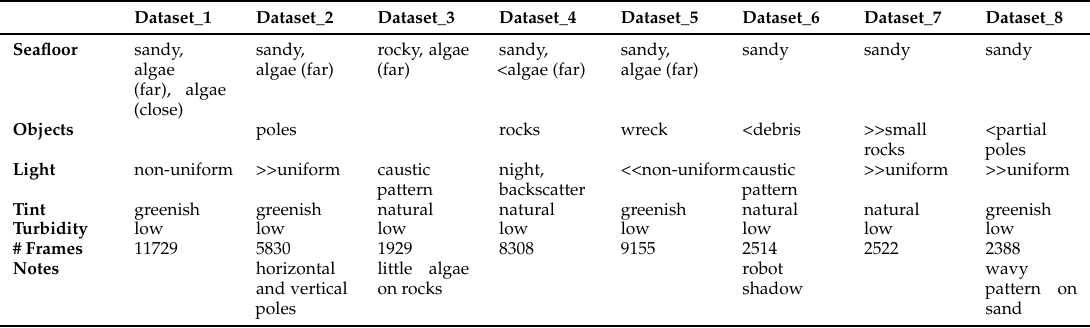
Table 3. Datasets characteristics. The symbols >> , > , < , << are used to indicate the quantity: most, moderate, low and few,